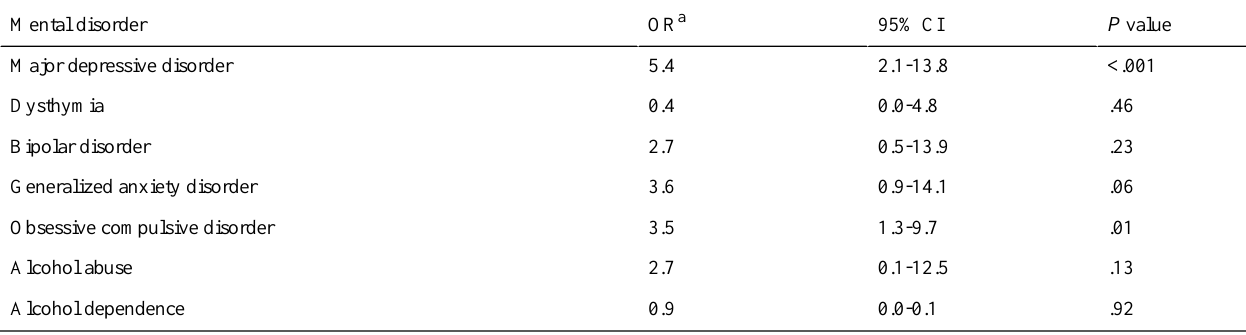
Table 2. Association of mental disorders and online support group use in the